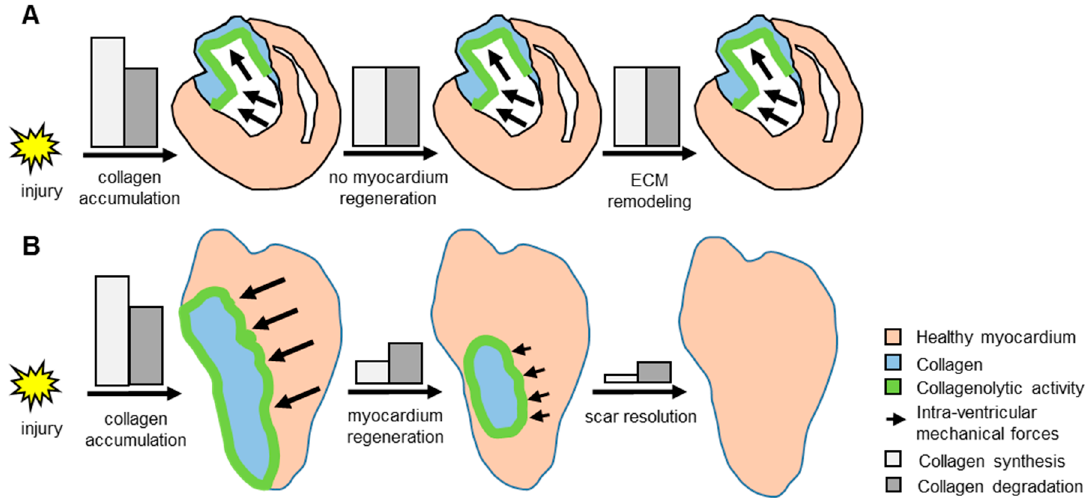
Figure 5. Model of potential scar resolution mechanism in zebrafish heart following injury. ( A ) In the neonatal mouse heart after transmural cryoinjury, damage to the hearts triggers both collagen synthesis and collagenolytic activity in the wound. The loss of cardiac muscle increases the intra-ventricular mechanical forces (represented by black arrows) which stimulates the synthesis of collagen. The absence of myocardium regeneration leads to a balance of intra-ventricular mechanical forces and of collagen synthesis/degradation, resulting in persisting collagen scar, and ECM remodeling; ( B ) In zebrafish, the injury induces a similar fibrotic response. However, when the myocardium is regenerating, the intra-ventricular mechanical forces decrease, leading to less collagen synthesis than collagen degradation, and eventually to the scar resolution.